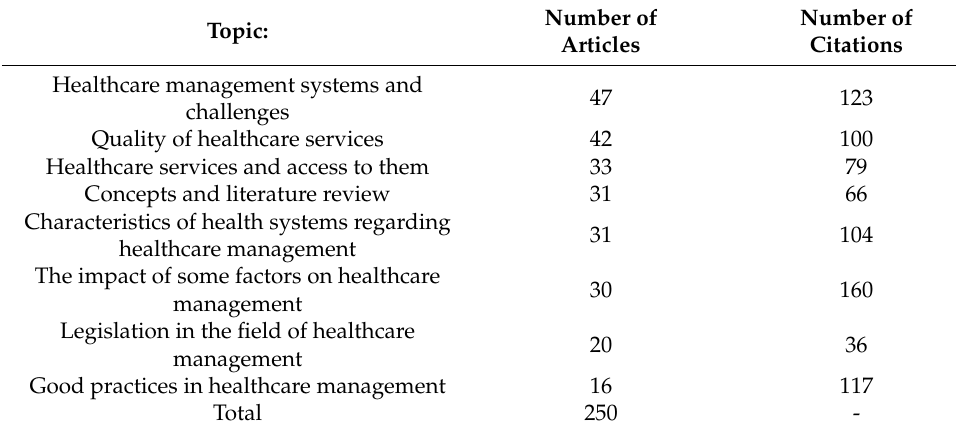
Table 4. Number articles and citations according to